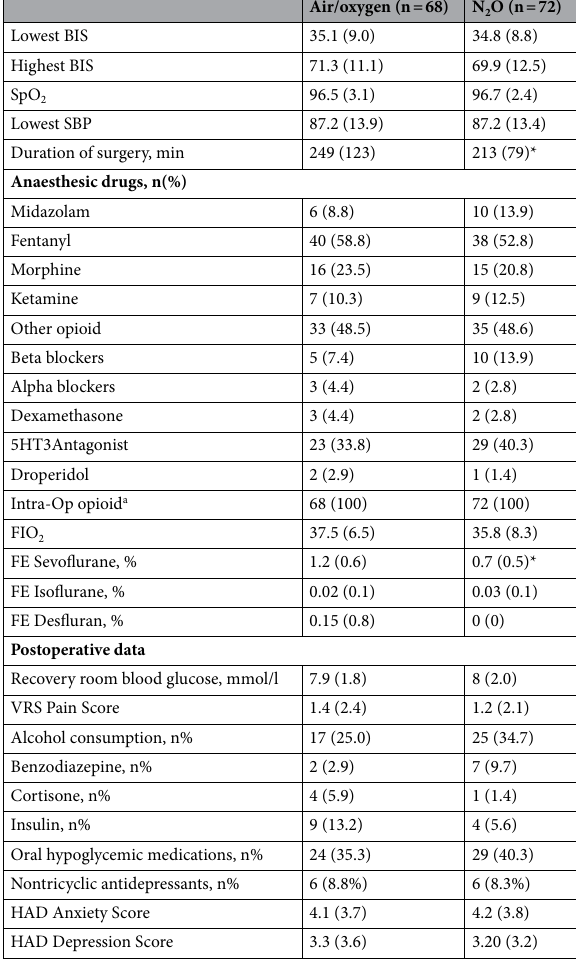
Table 2. Procedure and postoperative related data comparing patient in the N 2 O versus N 2 O-free anesthesia group. All data are presented as mean (± SD) except when specified N, (%). P < 0.05 following *t test for comparisons of means and Chi-2 test (or Fisher exact test) for comparisons of proportion. a Yes if intra-op fentanyl, morphine or other